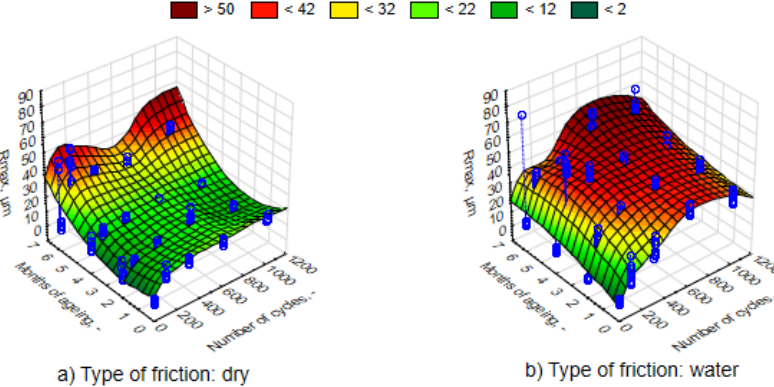
Figure 11. Characteristics of changes in parameter Rmax, depending on the number of dry friction cycles, for samples in different phases of weathering, ( a ) dry friction, ( b ) wet friction.